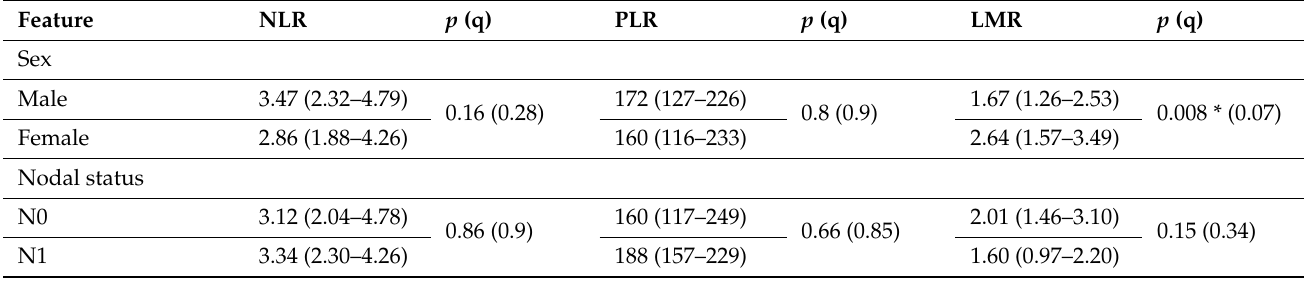
Table 2. Associations between morphological parameters and clinicopathological variables. Given values: median